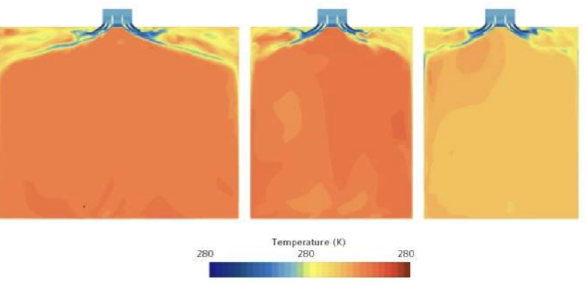
Figure 13. Numerical simulation: temperature field for Case 0 for Rooms 1 to 3 (left to right).